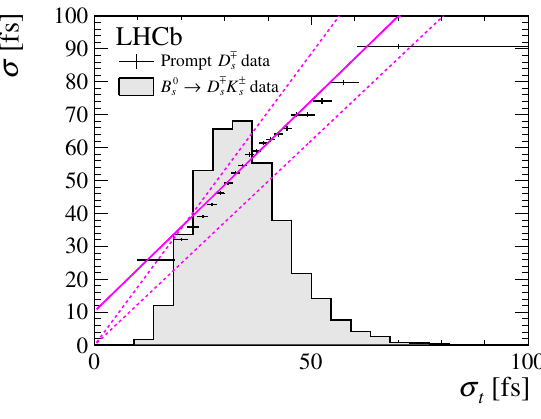
Figure 4 . Data points show the measured resolution (cid:27) as a function of the per-candidate uncer- tainty (cid:27) t for prompt D (cid:7) candidates combined with a random track. The dashed lines indicate the s values used to determine the systematic uncertainties on this method. The solid line shows the linear (cid:12)t to the data as discussed in the text. The histogram overlaid is the distribution of the per-candidate decay-time uncertainty for B 0 D (cid:7) K (cid:6) candidates. s ! s analytic way in the decay-time (cid:12)t [47]. The spline boundaries, knots, are chosen in order to model reliably the features of the acceptance shape, and are placed at 0 : 5, 1 : 0, 1 : 5, 2 : 0, 3 : 0 and 12 : 0 ps. In the sFit procedure applied to the sample of B 0 D (cid:0) (cid:25) + candidates, s ! s the CP -violation parameter C f is (cid:12)xed to unity with C f = C (cid:22) , while S f , S (cid:22) , A (cid:1)(cid:0) , f f f (cid:0)